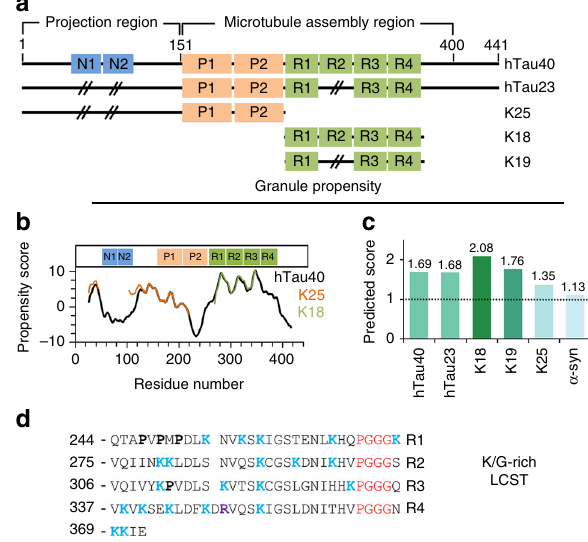
Fig. 1 The Tau sequence encodes a strong propensity for lower-critical solution transition and granule formation. a Domain organization of the Alzheimer-related protein Tau. The longest Tau isoform (2N4R, htau40) in the human central nervous system contains four imperfect repeats (R1 – R4) and two N-terminal inserts (N1, N2). htau23 (0N3R) is the shortest isoform and lacks the two N-terminal inserts as well as repeat R2. The Tau repeats form the core of NFTs 87 . The protein K25 contains only the N-terminal half of Tau, which is called the projection region. b Residue- speci fi c propensity score for granule formation predicted by catGranule for full-length 4R-Tau (hTau40), the repeat domain of 4R-Tau (K18), and K25. c Total catGranule-scores of different Tau proteins and α -synuclein ( α -syn). d Amino-acid sequence of repeat domain of Tau. It contains 19 lysine residues (highlighted in blue ) and four PGGG motifs ( red